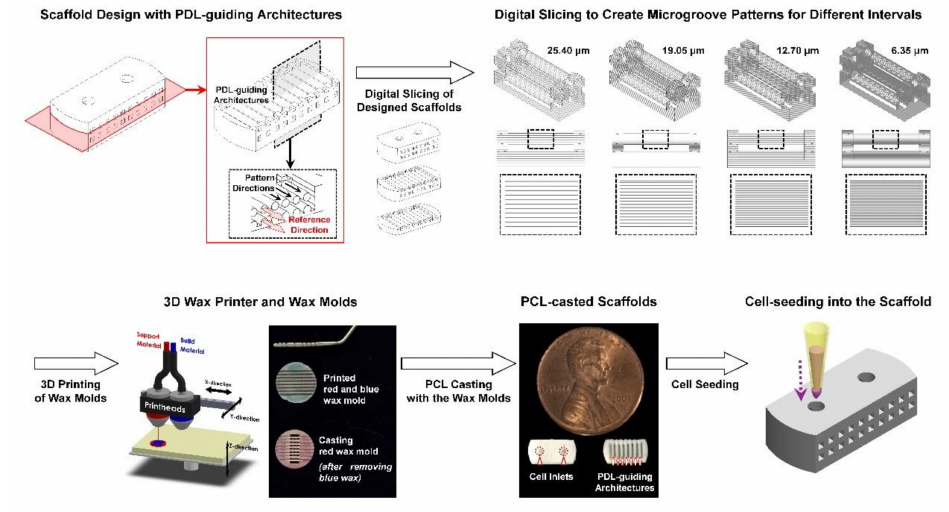
Figure 1. Four di ff erent sca ff olds were designed with four di ff erent microgroove pattern intervals during the digital slicing step. After setting layer-by-layer thickness (25.40 µ m, 19.05 µ m, 12.70 µ m, and 6.35 µ m), wax molds were additively manufactured and poly- ε -caprolactone (PCL) sca ff olds were casted. For investigation of in vitro cell alignments, human periodontal ligament (PDL) cells were seeded into the sca ff olds for 7-day